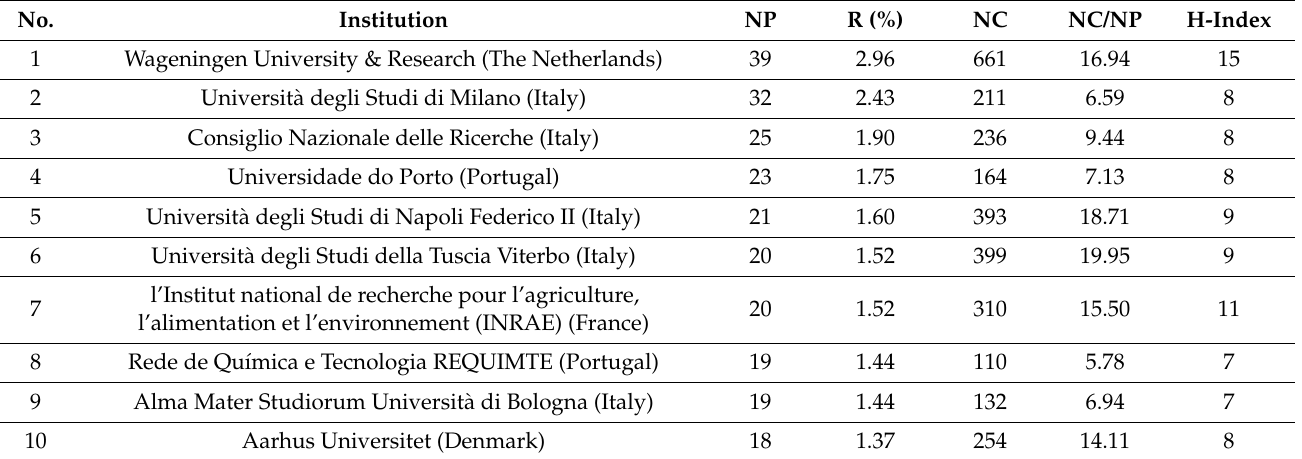
Figure 3. The co-operation network of core countries on circular economy and foods during 2012– 2021. Source: Authors’ elaboration. Table 3. Top 10 institutions in the volume of publications on circular economy and foods during